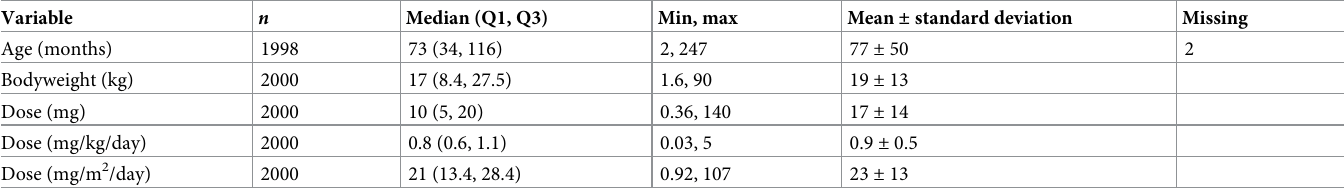
Table 1. Demographics of dogs (n = 2,000) prescribed prednisolone in Australian veterinary practices and dose prescribed. Variable